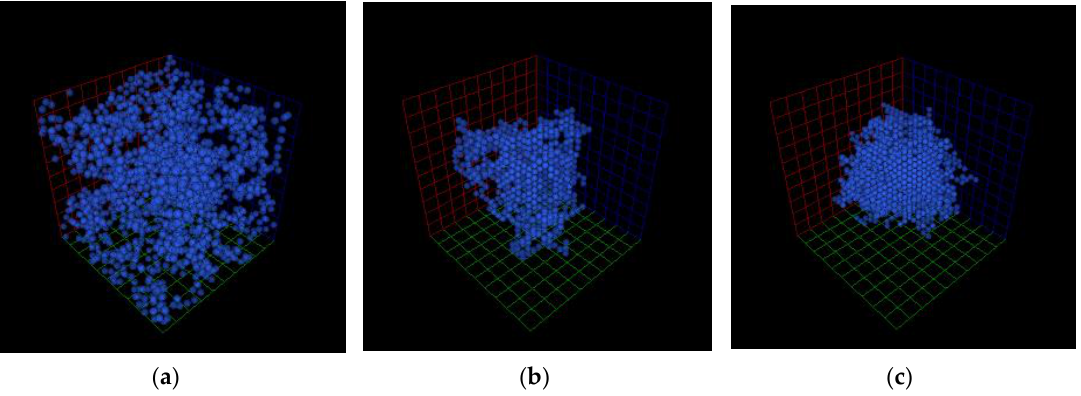
Figure 1. Porous structures generated by Reaction-Limited Cluster Aggregation (RLCA) ( a ), Diffusion-Limited Cluster Aggregation (DLCA) ( b ), and Ballistic Cluster–Cluster Aggregation (BCCA) ( c ) methods.